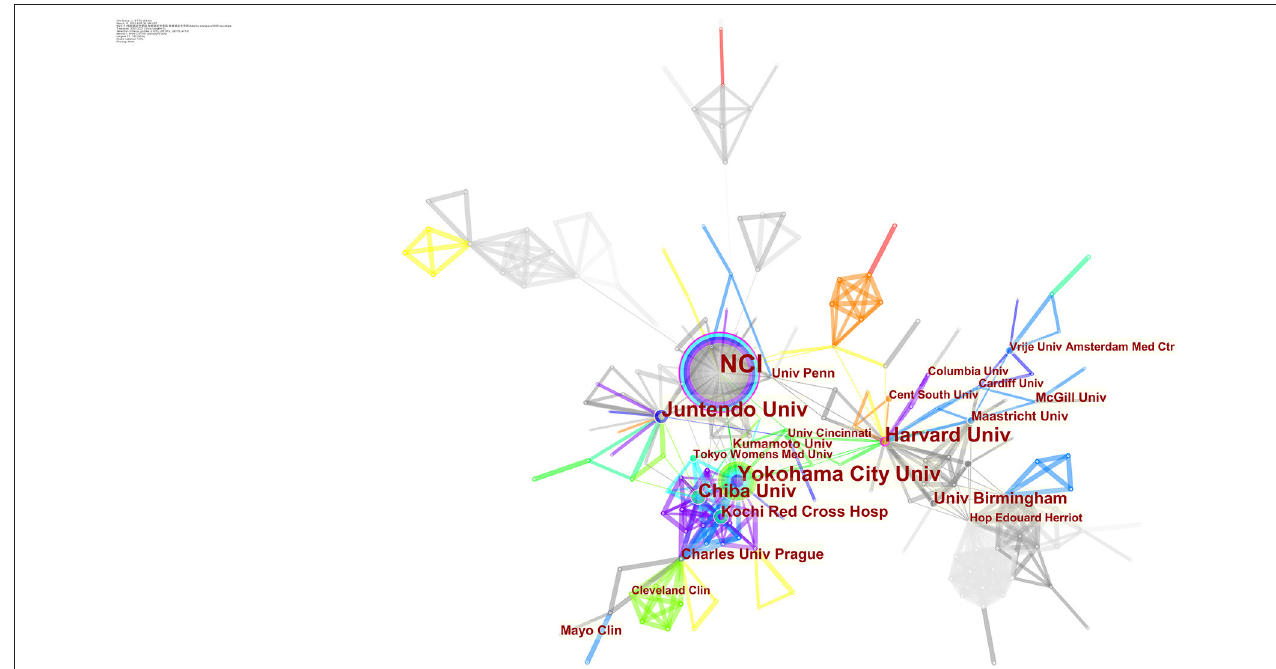
FIGURE 3 | CiteSpace network map of active authors in the field of BHD. Notes: Each circle represents an author. The size of the circle is proportional to the publication outputs, and lines between two circles represent a collaboration between two authors on the same article. Wider lines imply a stronger connection between scholars. Timespan: 2001-2021; Slice length = 1.